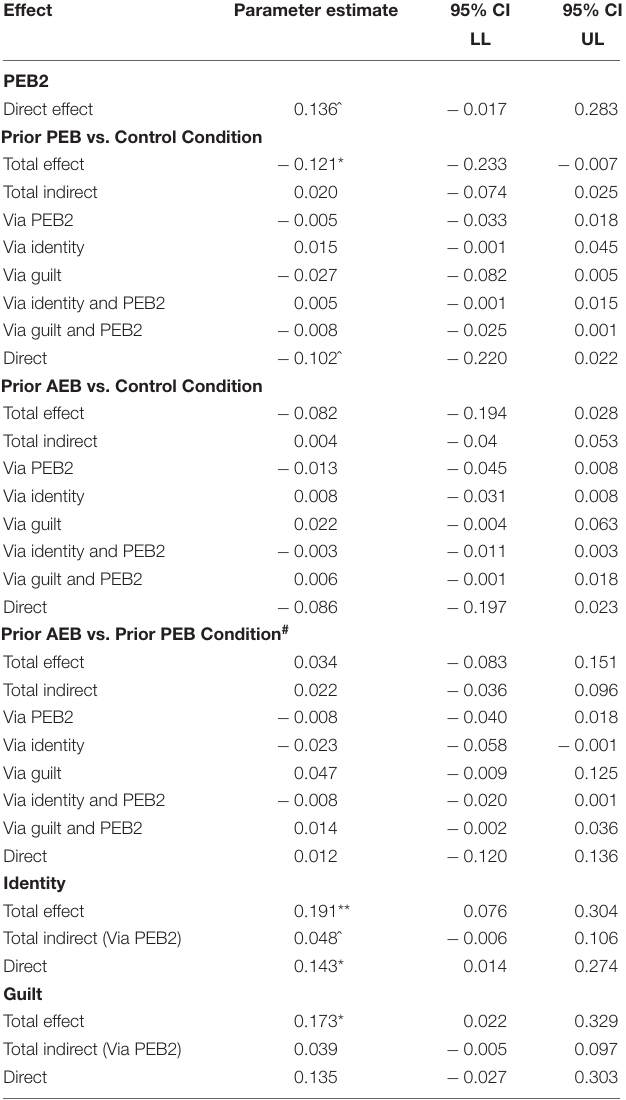
TABLE 3 | Standardized direct and indirect effects on PEB3 efficiency upgrade intentions, Study